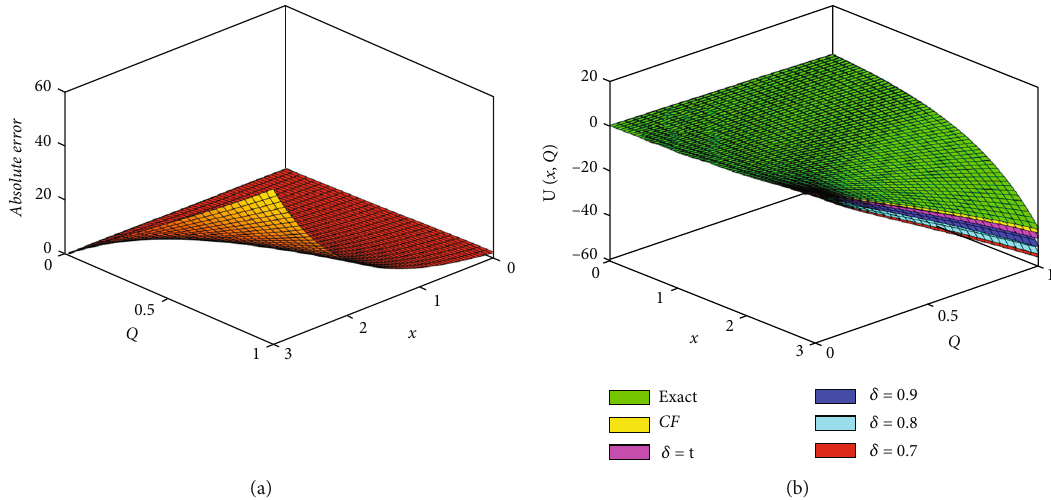
Figure 3: Three-dimensional illustration via the CFD of Example 1. (a) Absolute error. (b) Multiple